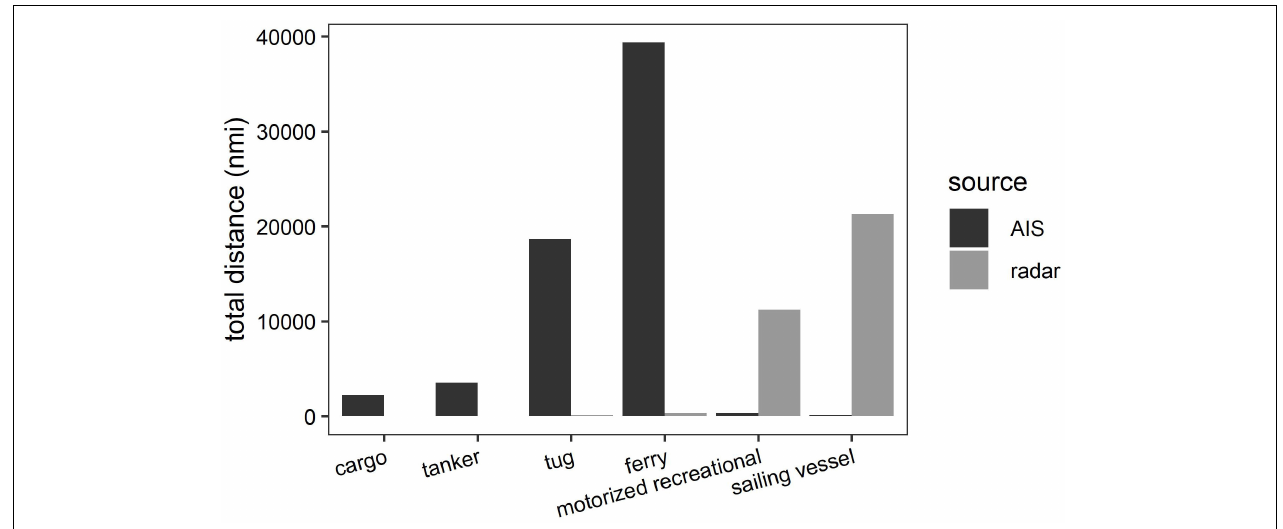
FIGURE 2 | Total distance traveled in the study area (in nmi) across 175 days of 24-h data acquisition for all major vessel classes. Distance traveled is separated by data source (AIS or radar). Motorized recreational and sailing vessel distance calculation did not include vessel transits at